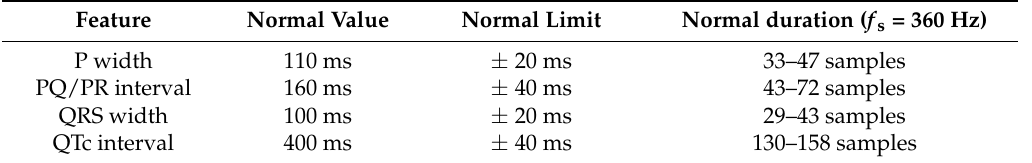
Table 1. ECG Sinus Rhythm Event Durations. The proposed algorithm depends on the estimate of the event duration before processing the ECG signal. The window sizes are set with expected event durations. There are three events of the ECG wave: P, QRS and T waves, all measured from a healthy male adult at a heart rate of 60 beats per minute (bpm). Here, f s stands for sampling frequency.